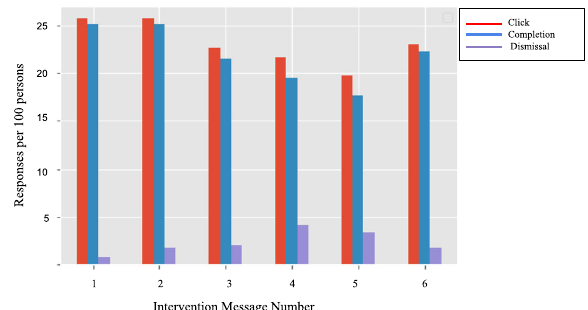
Fig. 6 Different response types among PWD-I for each interven- tion message. Depicts the levels of engagement and different response rates for each intervention from the PWD-I: People with diabetes-intervention